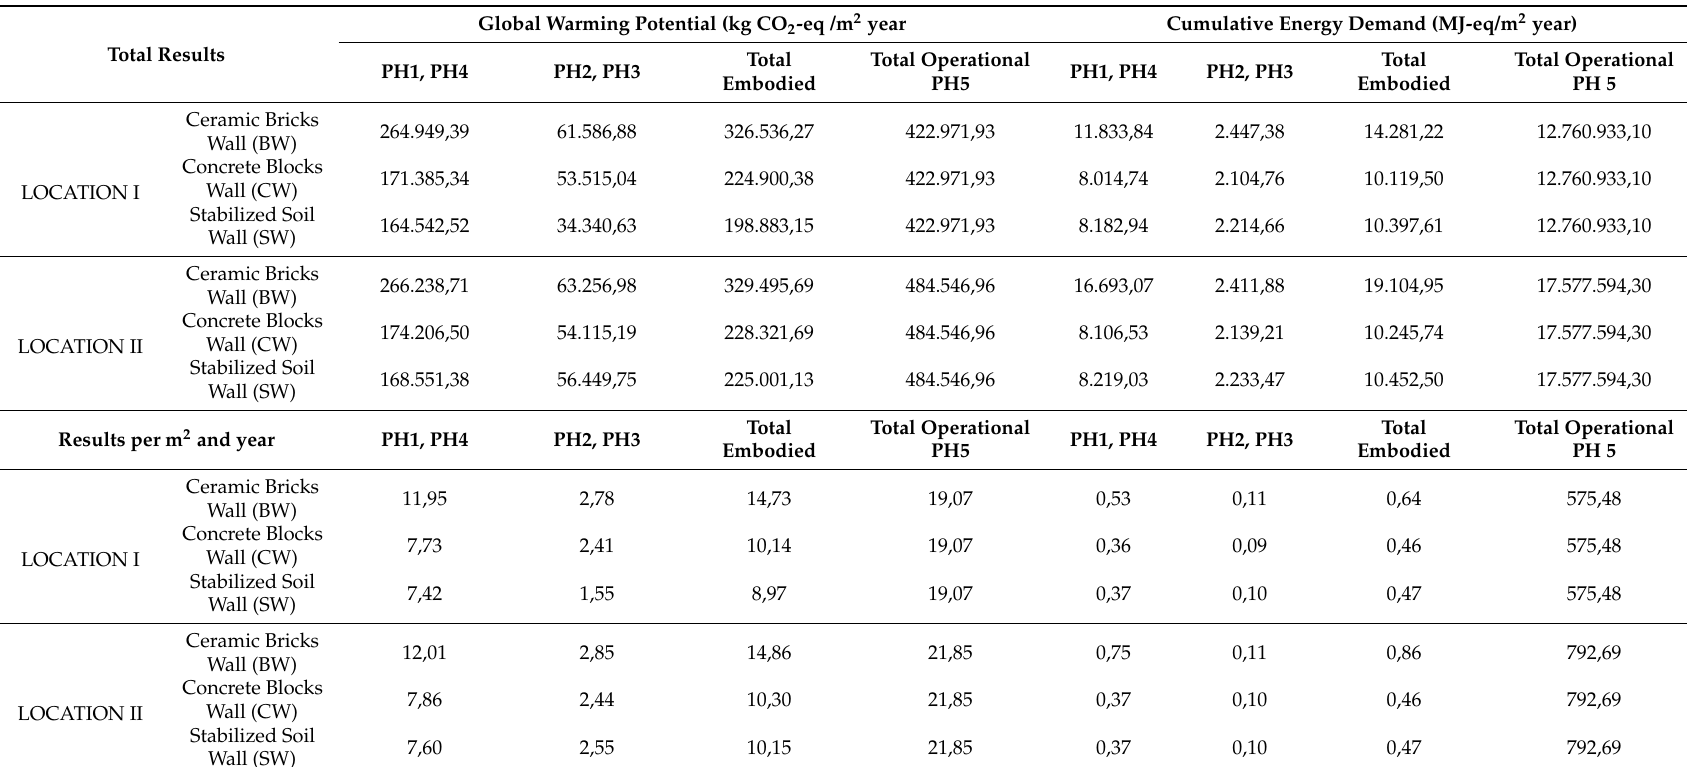
Table 5. Mean environmental impact values showed by type of building construction system and climate